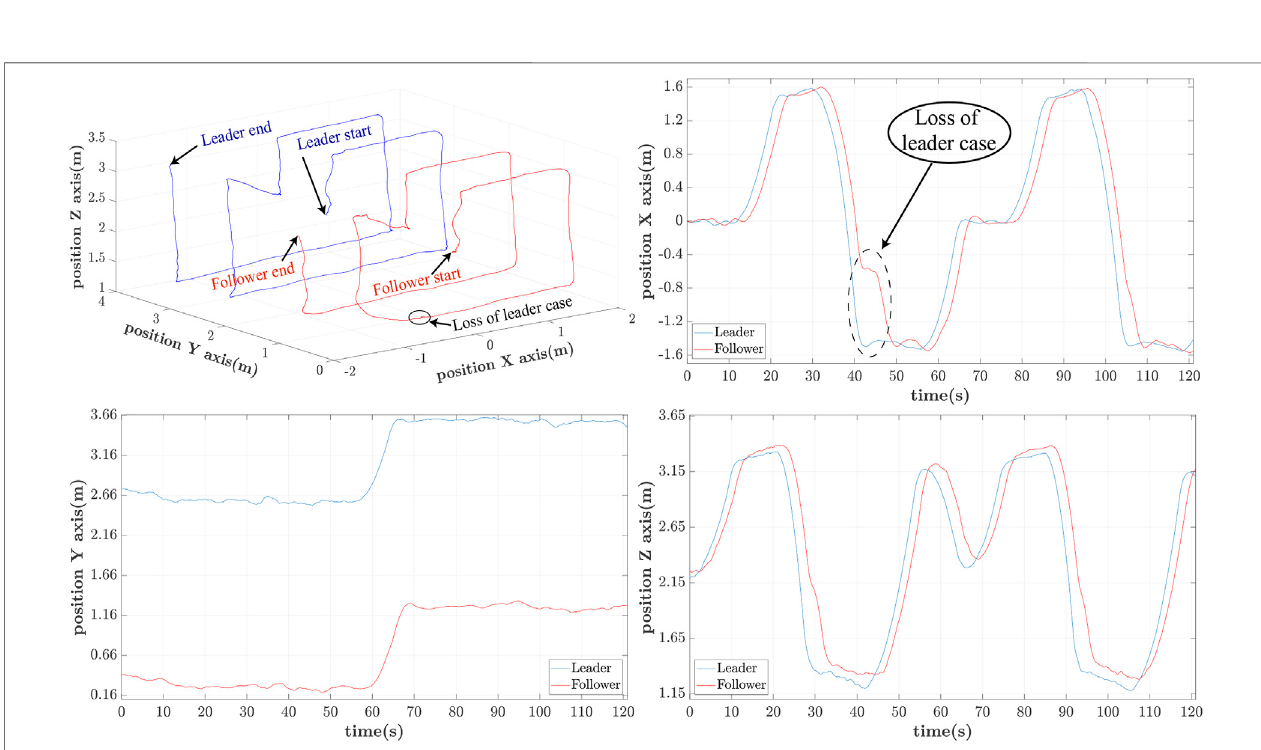
FIGURE 11 | 3D Leader/Follower trajectories with h (cid:2) 1s delay.